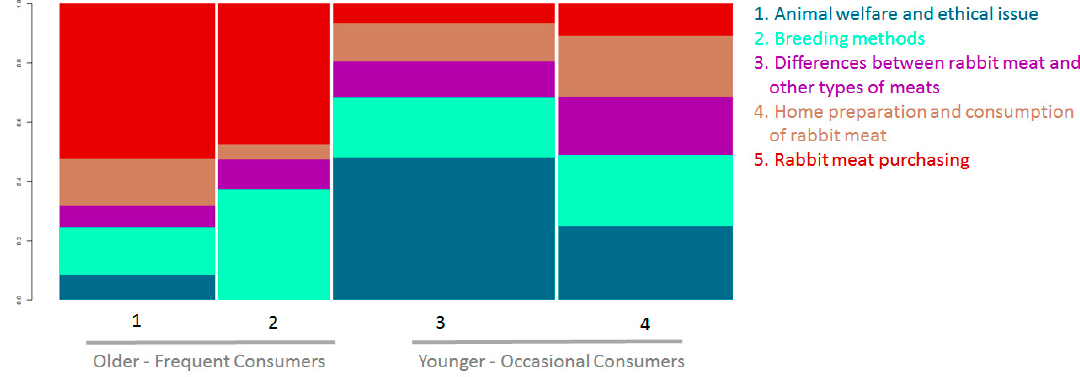
Figure 3. Distribution of the clusters identified among the four focus groups.